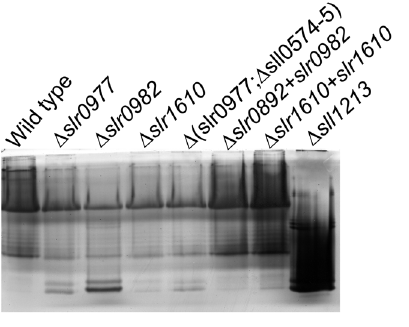
Figure 4. Purified LPS analysis from the adhesive mutants: D slr0977, D slr0982, D s l r1610 and D ( slr0977; D sll0574-5 ). LPS was purified from wild-type (WT) or the corresponding mutants. Samples were analyzed by 12% SDS-PAGE and silver